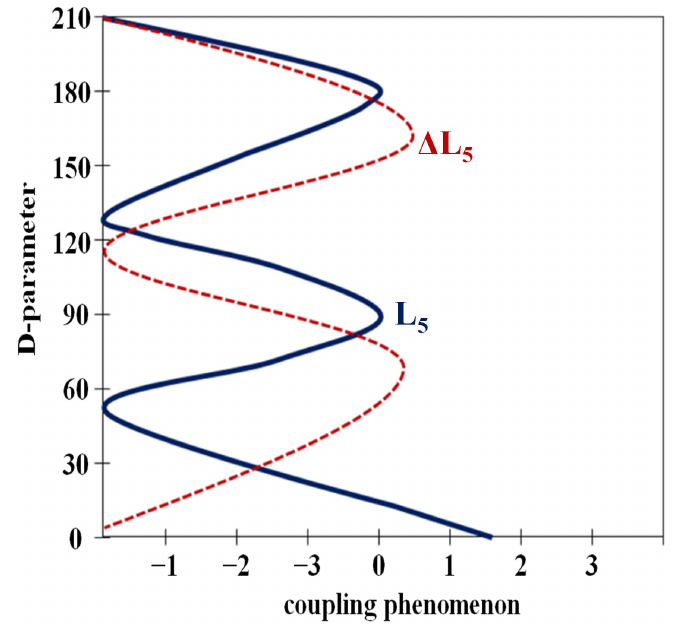
Figure 7. Coupling phenomenon corresponding to the variation of joint (D).